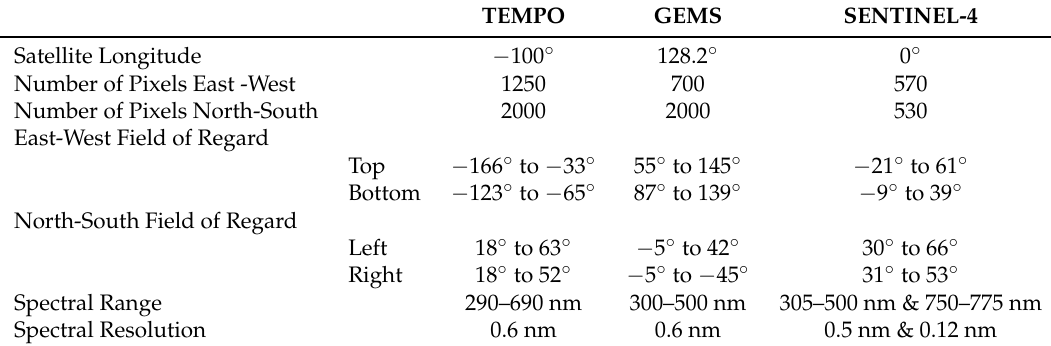
Table 1. Instrument specifications for the geostationary constellation.